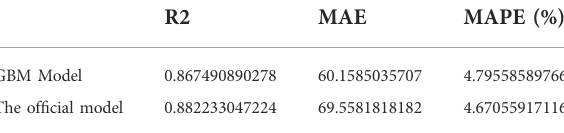
TABLE 5 The prediction result